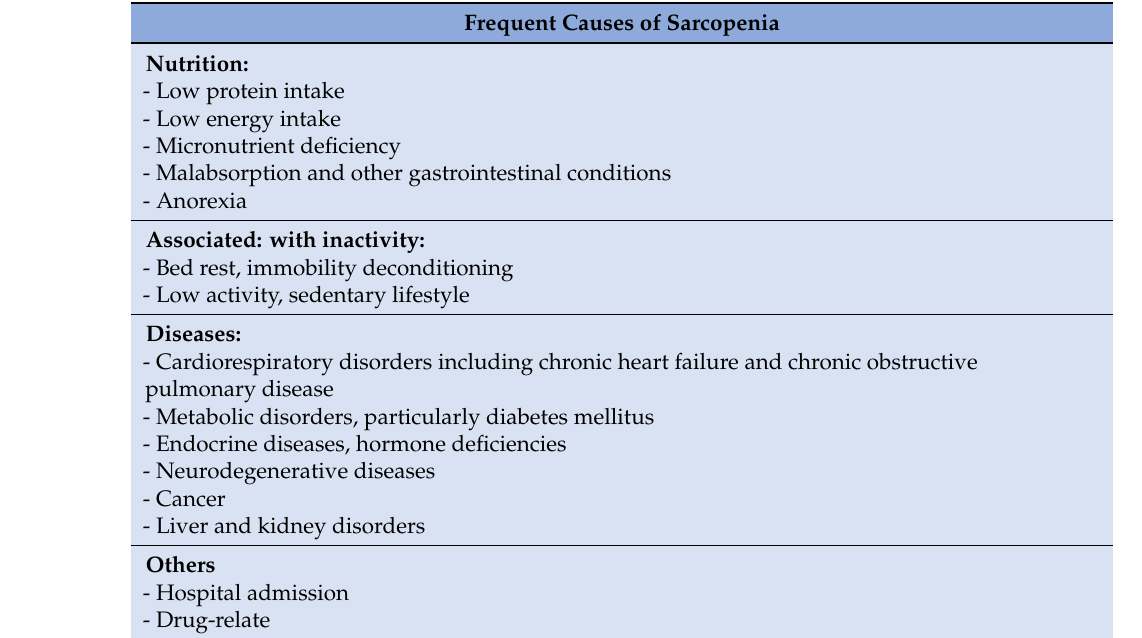
Table 2. Frequent causes of